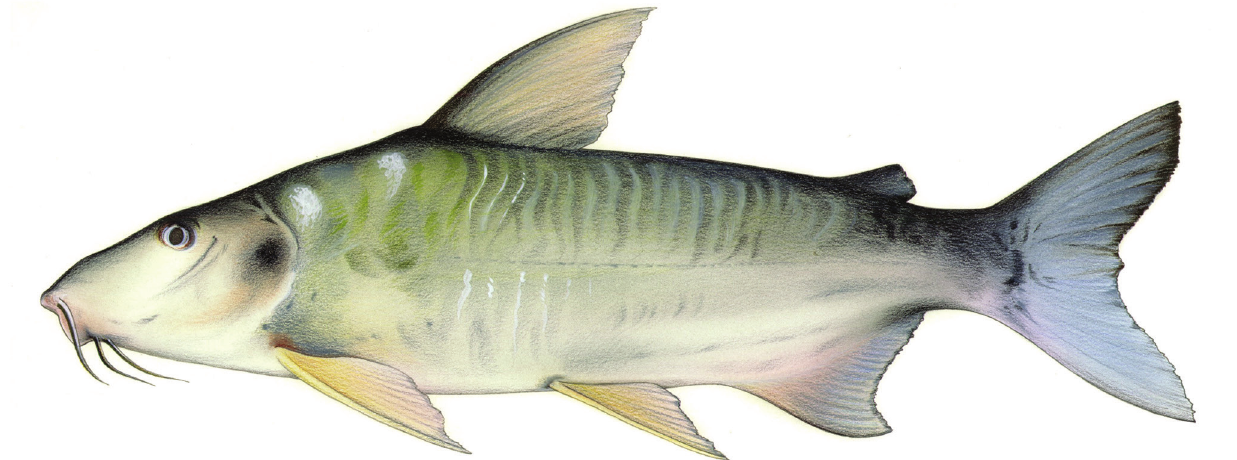
Fig. 1. Conorhynchos conirostris , pirá (drawing by Paulo Henrique